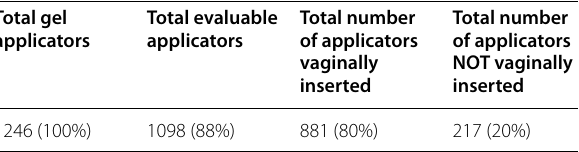
Table 1 Determination of vaginal insertion of total evaluable applicators